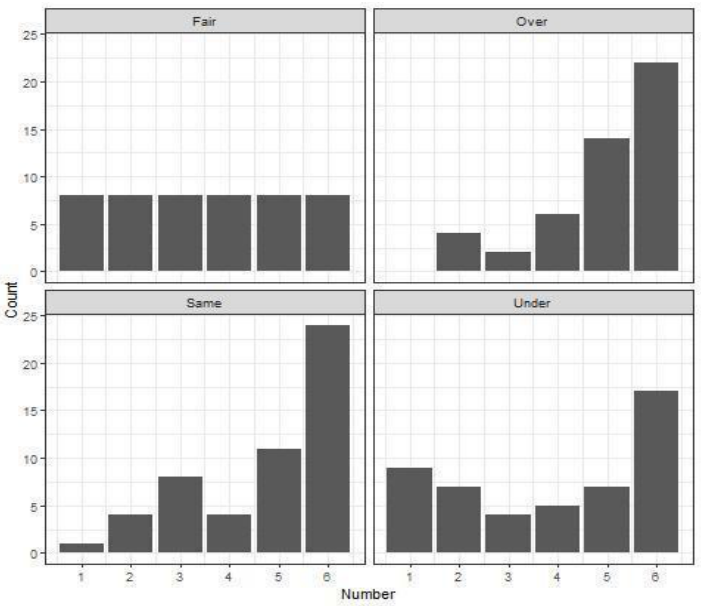
Figure 1: The distributions of rolling results among different groups; Source: Authors